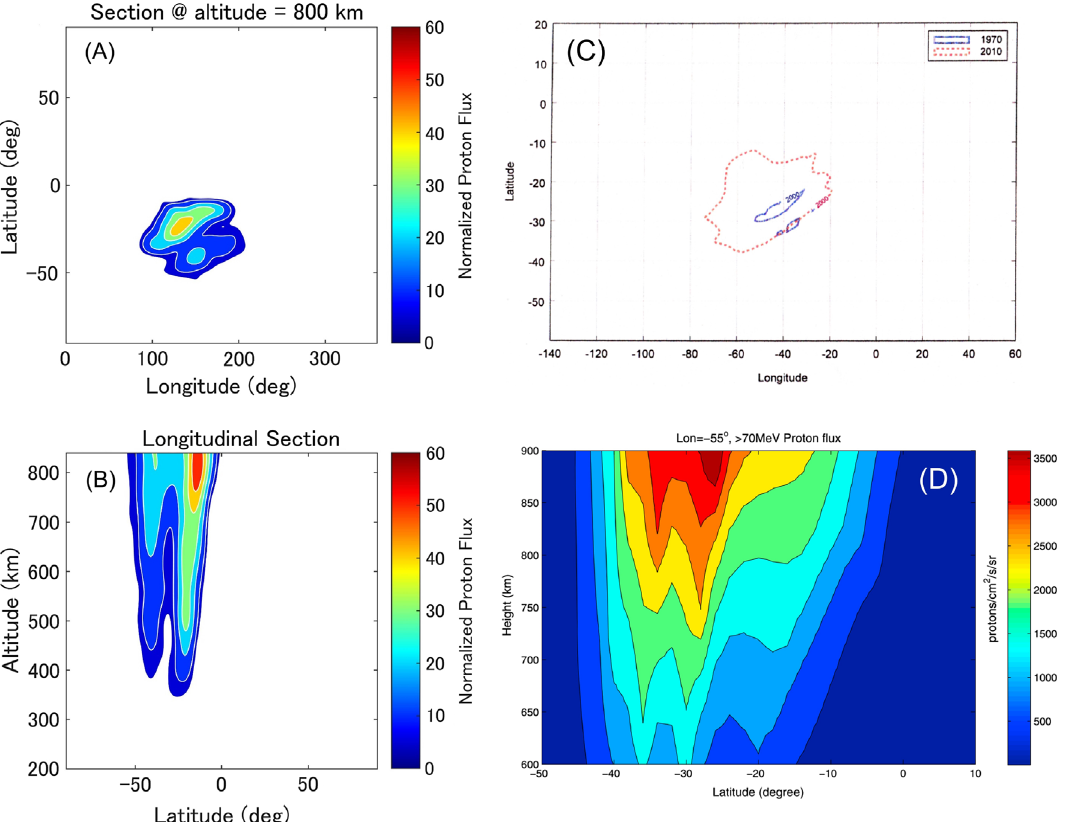
Fig. 5. The fi gure demonstrates a comparison between the numerical SAA proton fl ux (panels A and B) and the output results of the AP8MAX model (panel C) of Stassinopoulos et al. (2015), showing the E > 100 MeV proton fl ux at 800 km altitude for both years 1960 and 2010, in addition to the AP8 model results (panel D) of Zou et al. (2015), showing the E > 70 MeV proton fl ux contours at Longitude = (cid:6) 55